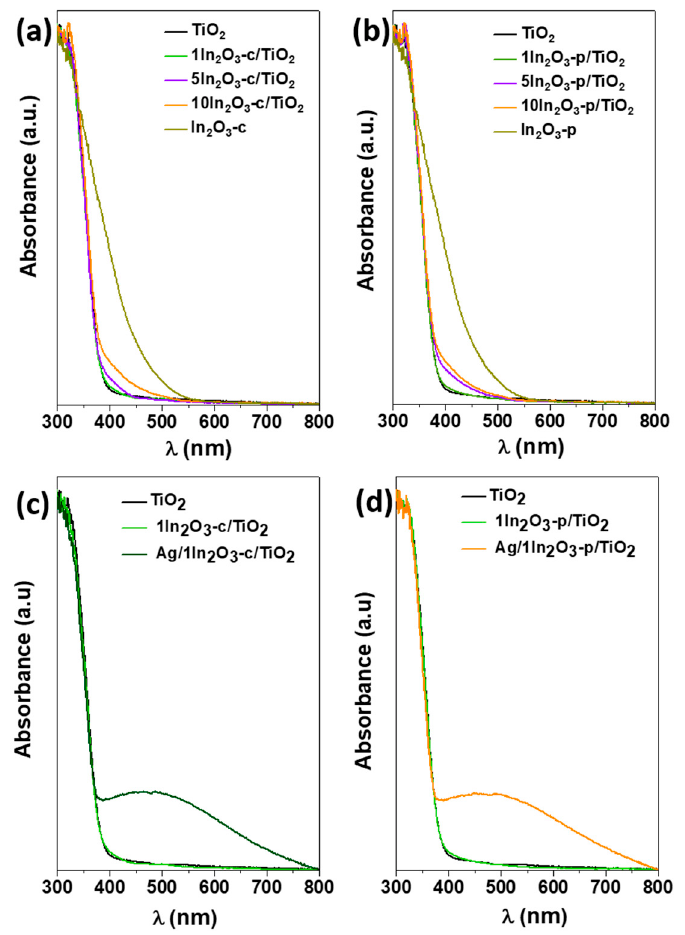
Figure 3. UV/Vis diffuse reflectance spectra of all catalysts studied compared to TiO 2 : ( a ) c-series, ( b ) p-series, and ( c , d ) ternary catalysts compared to their binary counterparts.